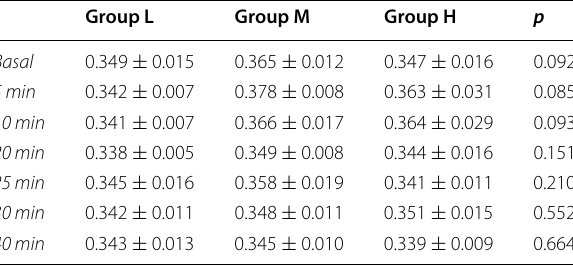
Table 2 Presentation of mean corrected QT values (mean SD) for three different sugammadex dose groups through ± experiment by intervals, calculated by Bazett method on ECG recordings. There was no significant statistical difference